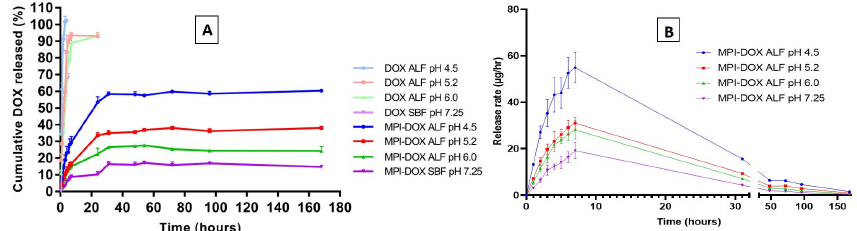
Figure 4. ( A ) Cumulative doxorubicin release profiles from free doxorubicin and the pH-dependent doxorubicin release from MPI-doxorubicin by dialysis in ALF and SBF at 37 °C. ( B ) Release profile of doxorubicin from MPI-doxorubicin in different pH release medium. Data are presented as the mean ± SD ( n = 3).